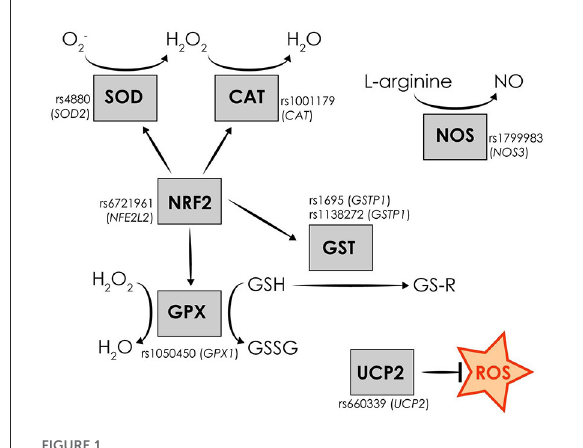
FIGURE1 Schematic representation of the investigated oxidative stress-related genetic variants and the function of the encoded oxidative stress-related proteins.